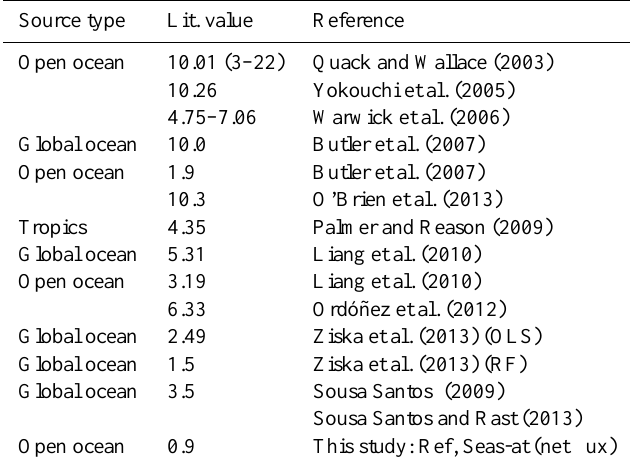
Table 3. Previously reported and simulated global annual bromo- form net emissions (GmolBryr − 1 ) from the